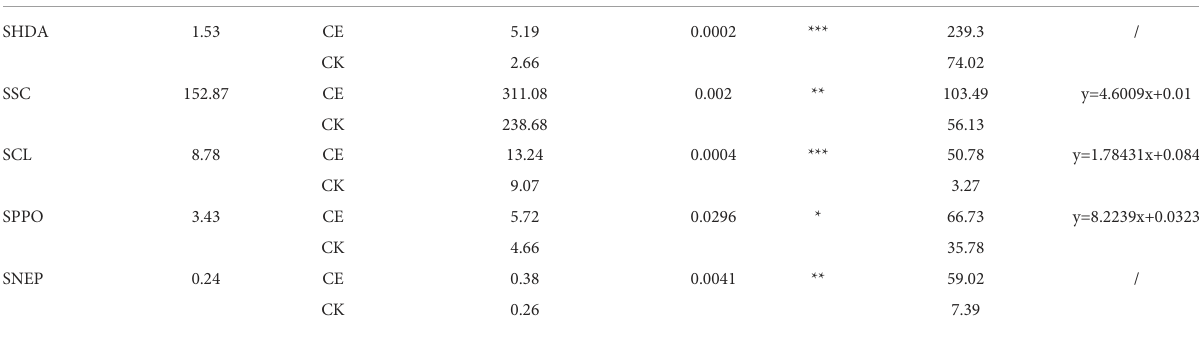
TABLE 1 Difference of enzyme vigor between CE and CK in rhizosphere soil. Soil enzyme Original value (U/g